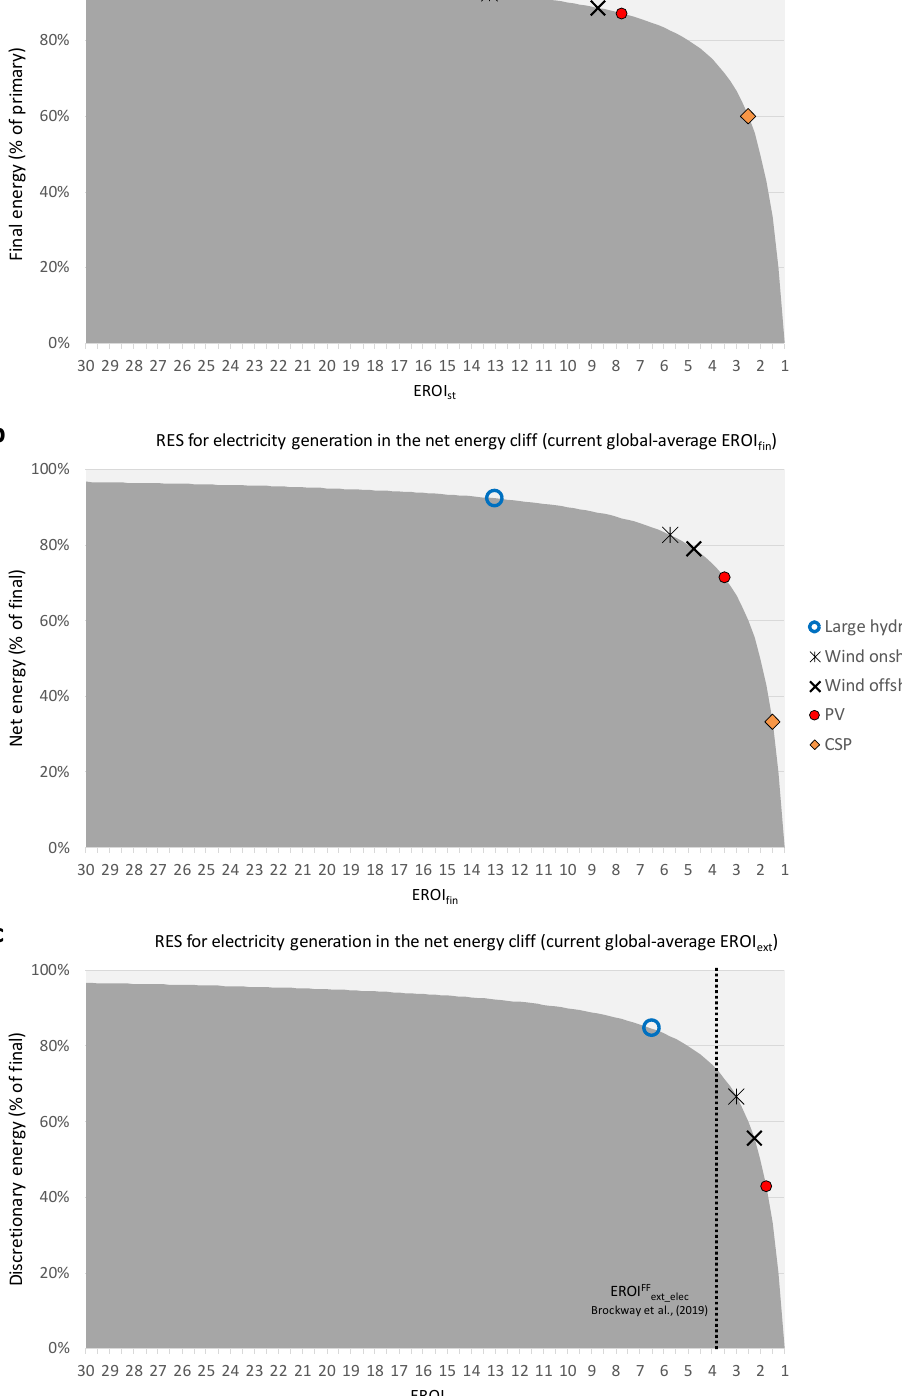
Figure 6. Current global average EROI of each RES technology for electricity generation at ( a ) standard; ( b ) final; ( c ) extended level represented as a share of the resulting share of net power vs gross power in the net energy cli ff . CSP is not represented in figure ( c ) since its EROI ext < 1:1. The figure ( c ) also shows the approximated value of 3.9:1 (black dotted line) for the global-average EROI ext for fossil fuels-fired electricity re-estimated from Brockway et al. [16] to adapt of our methodology (see Appendix D for the